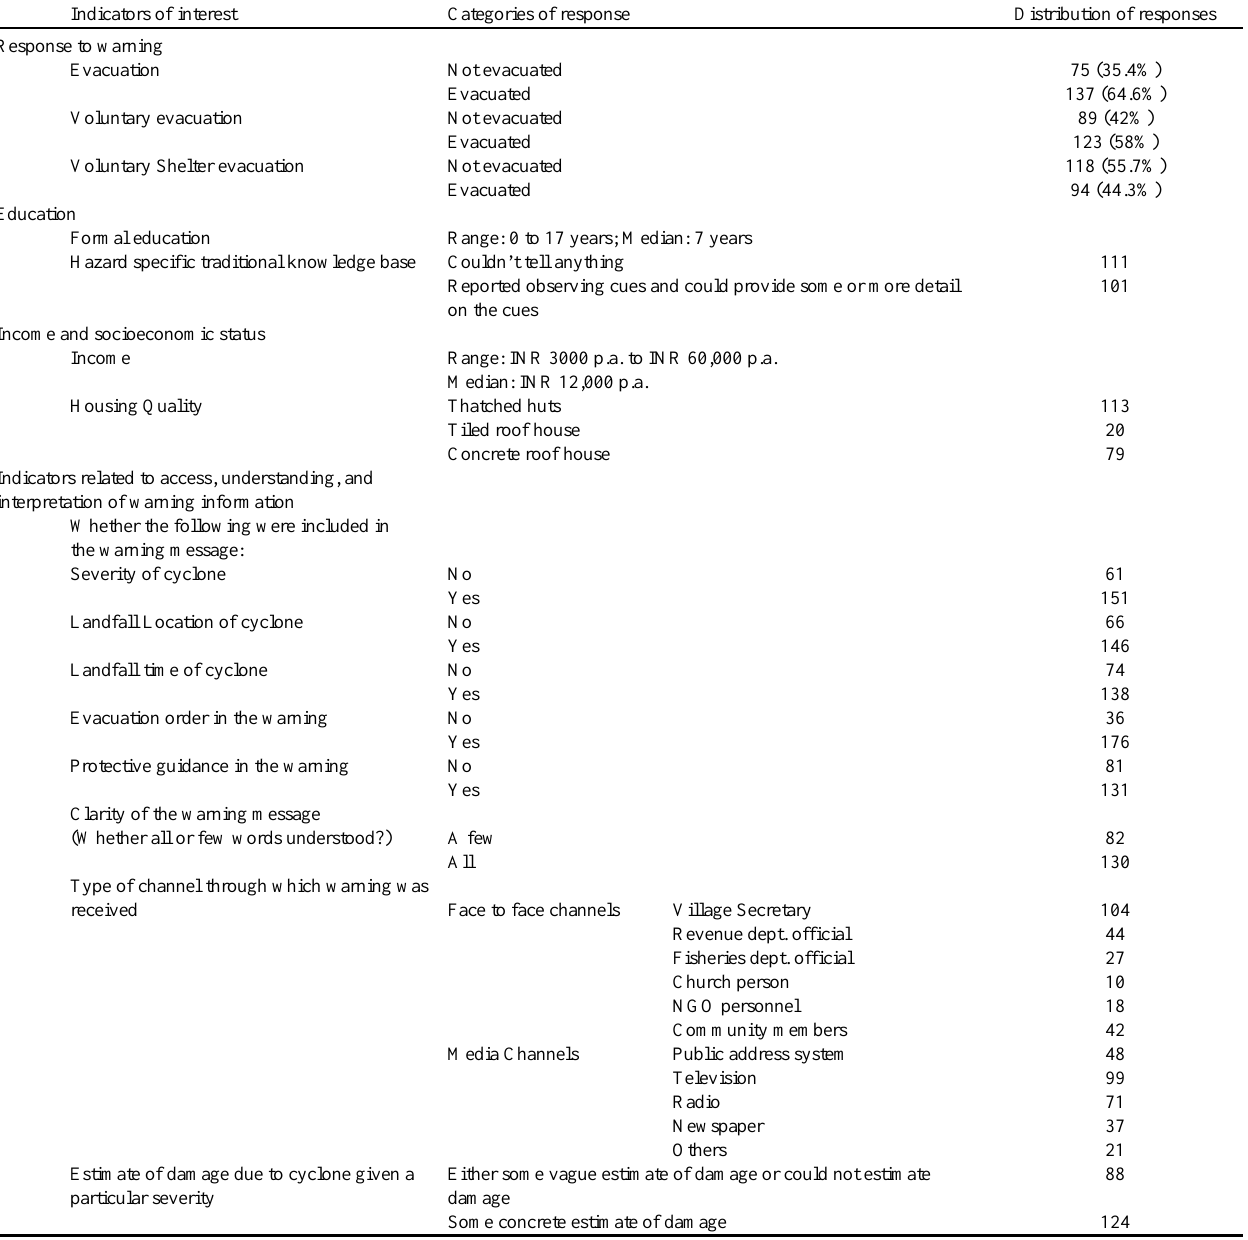
Table 1 . Summary of variables used in the